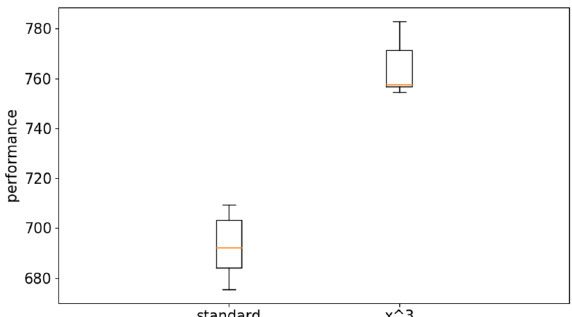
Figure 10. Performance of the agents evolved with the Steady State algorithm on the double pole balancing problem with the standard and with the curriculum learning version of the algorithm. The latter data refers to the experiments performed with the cubic difficulty function. Boxes represent the inter-quartile range of the data and horizontal lines inside the boxes mark the median values. The whiskers extend to the most extreme data points within 1.5 times the inter-quartile range from the box.